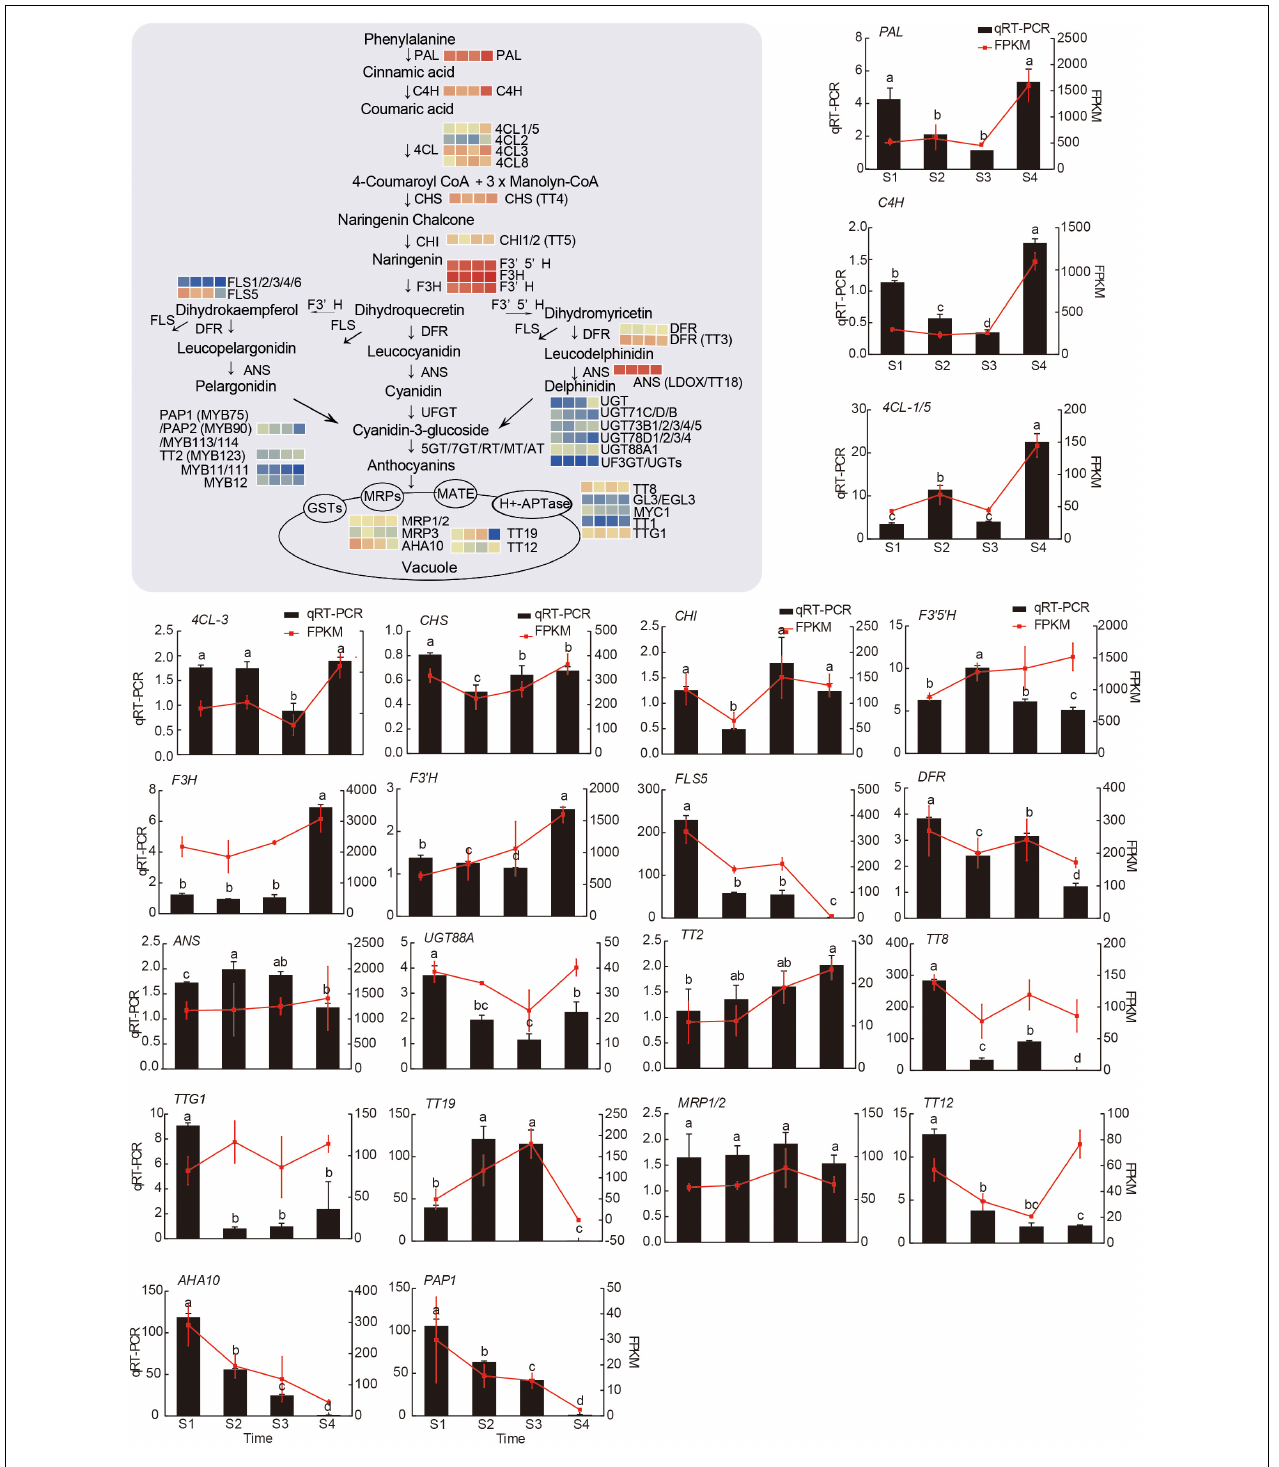
FIGURE 7 | The model diagram of the main anthocyanin biosynthesis pathway, and transcriptional analysis of and qRT-PCR assays of 21 genes associated with anthocyanins metabolism. R-package heatmaps were applied to map the expression heatmap of these genes. The heatmap data were homogenized by log2 (FPKM). The relative expression levels of target genes were calculated using the 2 − (cid:49)(cid:49) Ct method and the CcUBC9-5 was taken as an internal control. Experiments were carried out with three independent biological replicates and three technical replicates. Different letters represented significant differences ( P < 0.05, Tukey’s HSD) by ANOVA among